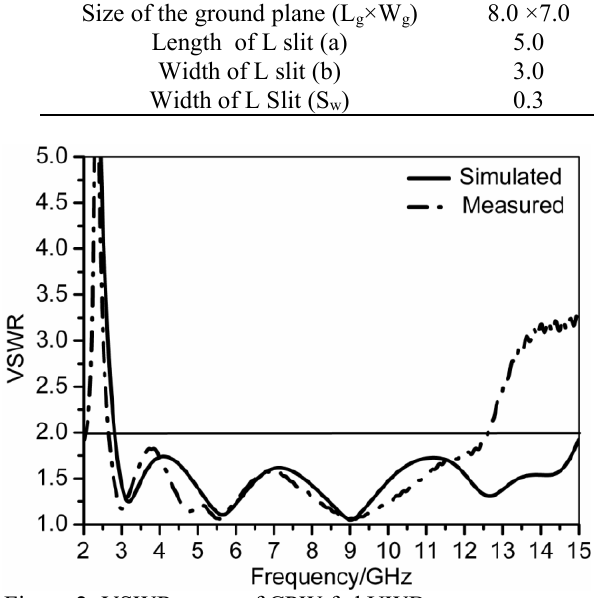
Figure 2: VSWR curve of CPW fed UWB